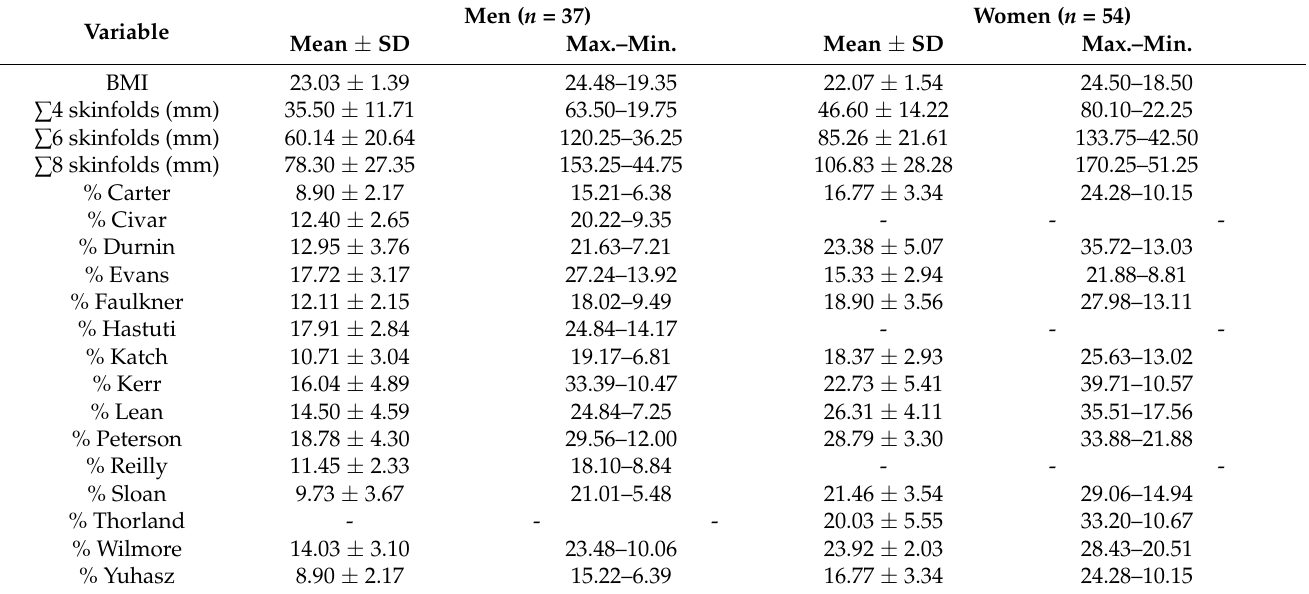
Table 2. Descriptive analysis of anthropometric variables and lipid percentages in men and women.